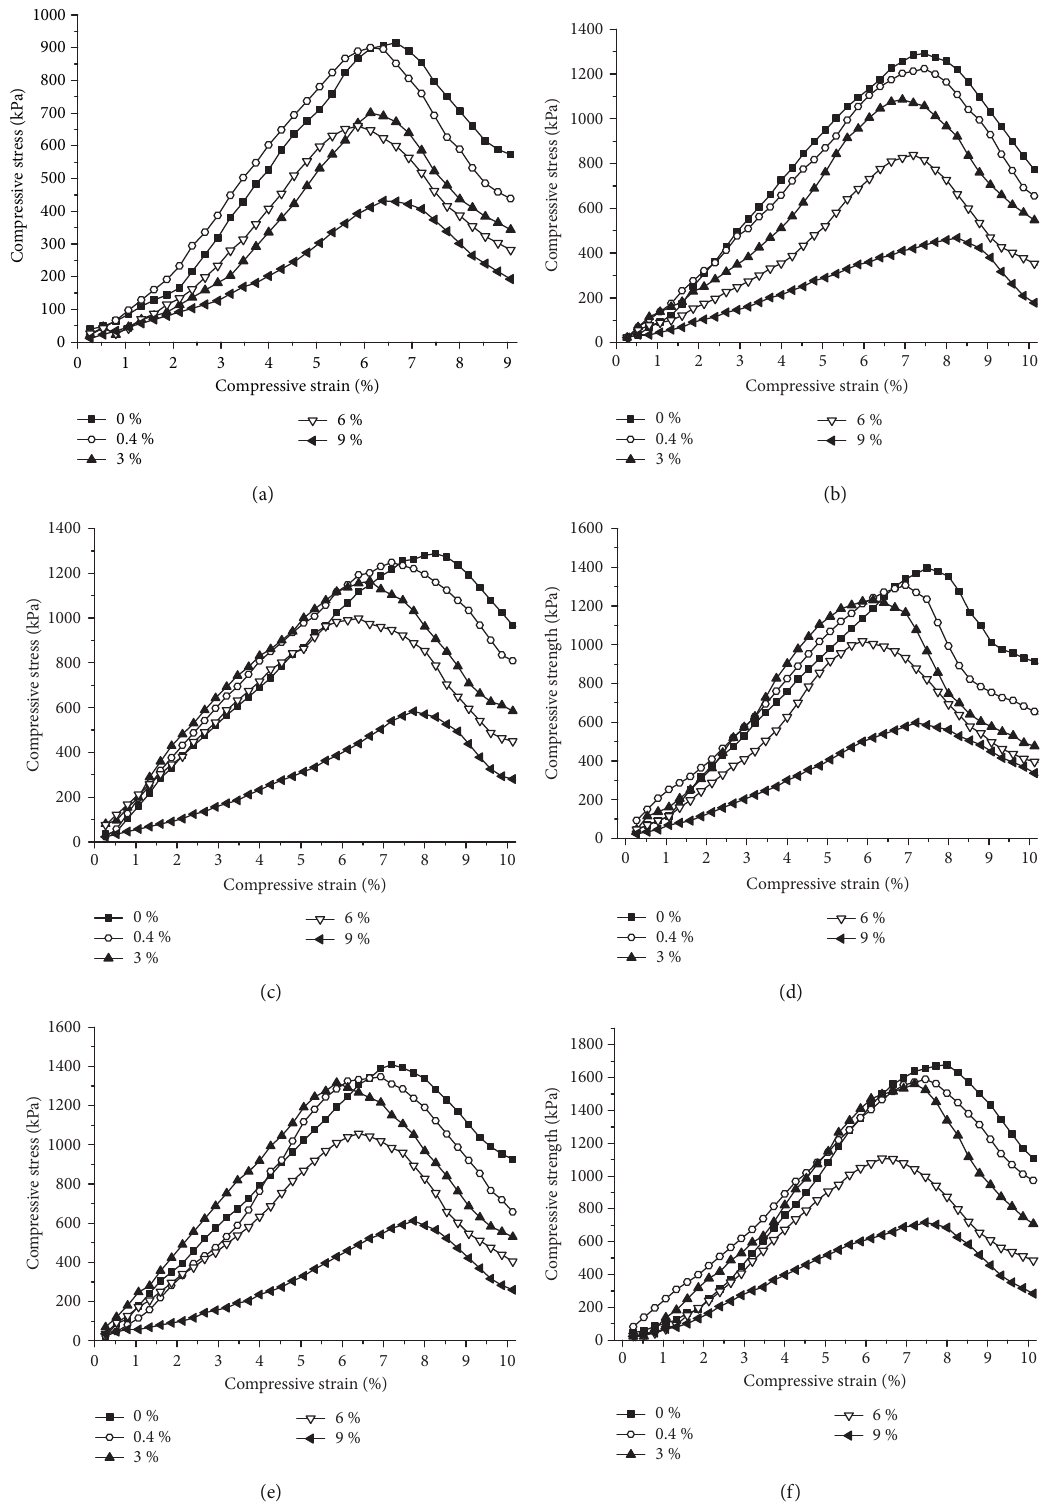
Figure 4: Compressive strength and compressive strain of specimens with di ff erent salt contents after seven days of curing: (a) 0% ZM, (b) 0.3% ZM, (c) 0.6% ZM, (d) 0.9% ZM, (e) 1.2% ZM, and (f) 1.5%